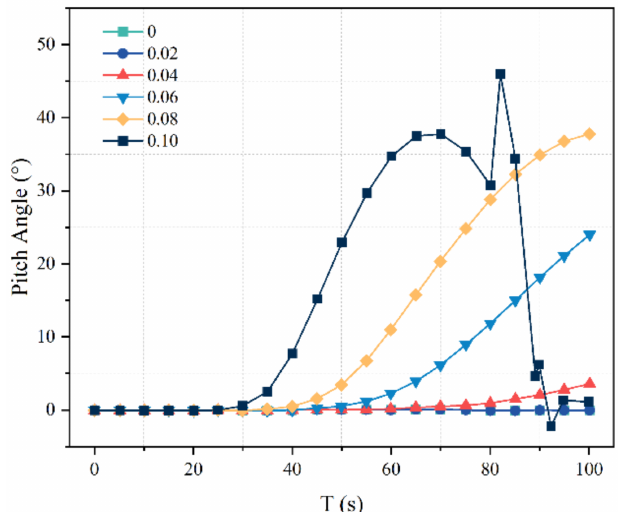
Figure 4. Pitch angle under different Munk moment